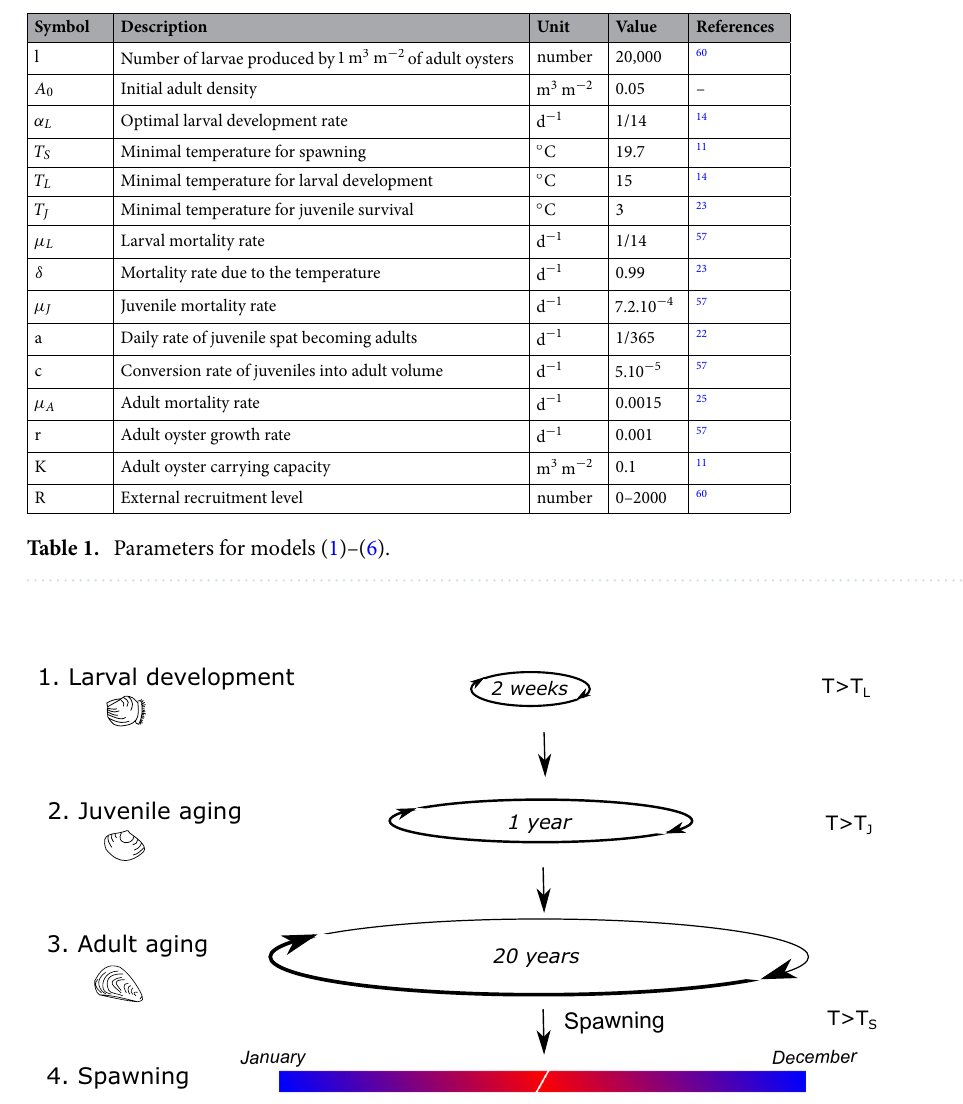
Figure 7. Oyster life-cycle: (1) Larvae are at a planktonic free-living stage, and develop and settle as juvenile spat above T L in a couple of weeks. (2) Juvenile spat are permanently attached to a substrate and develop into adult in 1–3 years. Juvenile spat cannot survive under T J and do not reproduce. (3) Adult oyster can live 20 years and up to 40 years and produce larvae. (4) In temperate regions, spawning occurs in warm months when the spawning temperature T S is